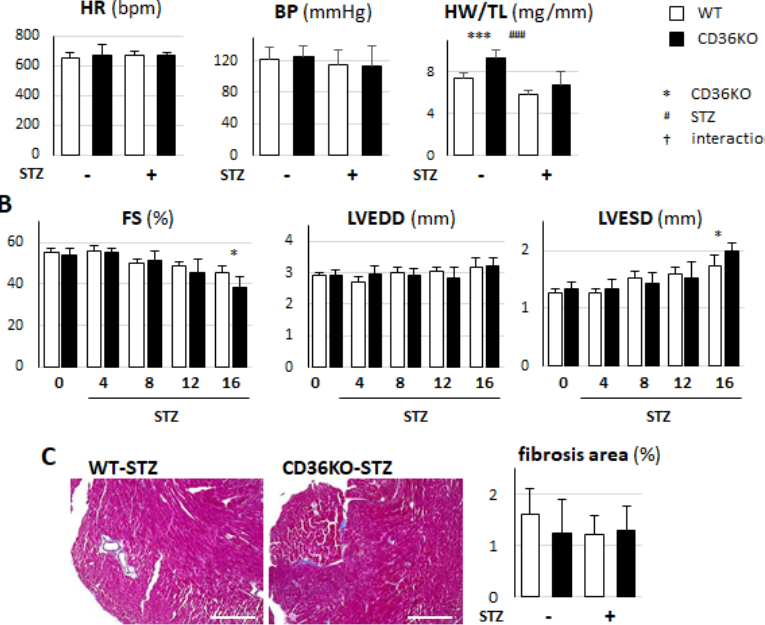
Figure 1. Cardiac contractile dysfunction was more greatly deteriorated in CD36KO-STZ mice. ( A ) Heart rate (HR) and systolic blood pressure (BP) were not significantly different between the two groups. Heart weight/tibial length (HW/TL) ratio was significantly reduced 16 weeks after STZ treatment. ( B ) Cardiac function was estimated by echocardiography before STZ treatment and 4, 8, 12 and 16 weeks after ( n = 10–12). FS, fractional shortening; LVEDD, left ventricular end-diastolic diameter; LVESD, left ventricular end-systolic diameter. ( C ) Cardiac fibrosis was estimated by Masson’s trichrome stain ( n = 6). Scale bar = 200 µm. * p < 0.05, *** p < 0.001; main effect for genotype. ### p < 0.001; main effect for STZ treatment.